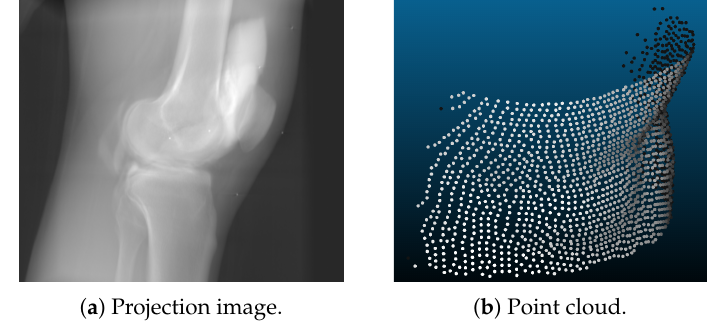
Figure 2. Simulated projection image ( a ) with its corresponding point cloud ( b